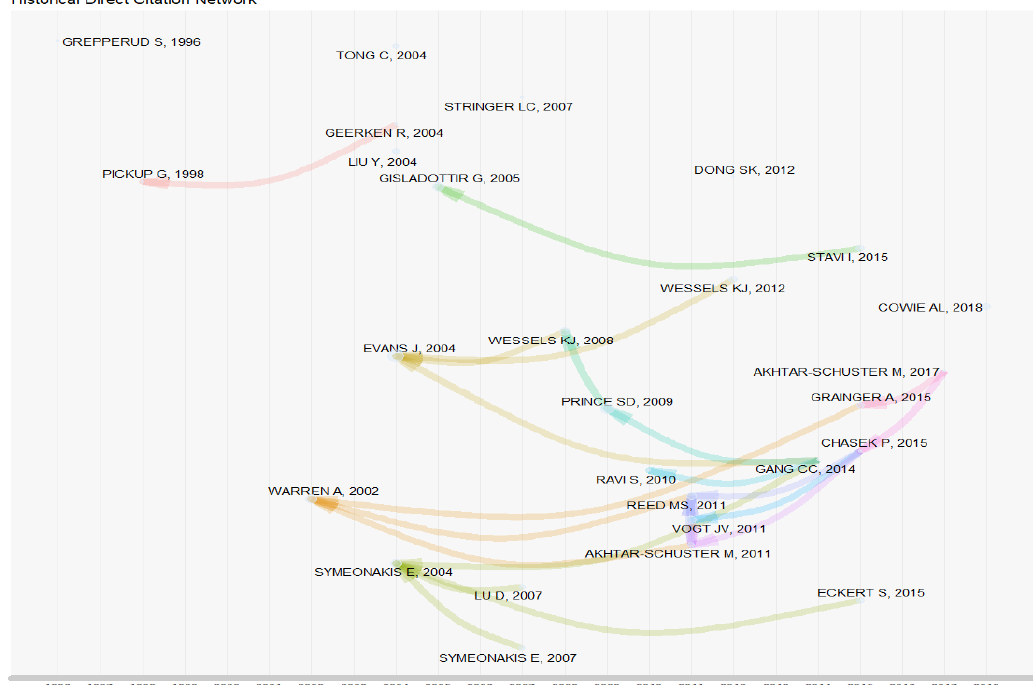
Figure 4. Historical direct citation network of top-cited papers in the field of land degradation from 1990 to 2019.